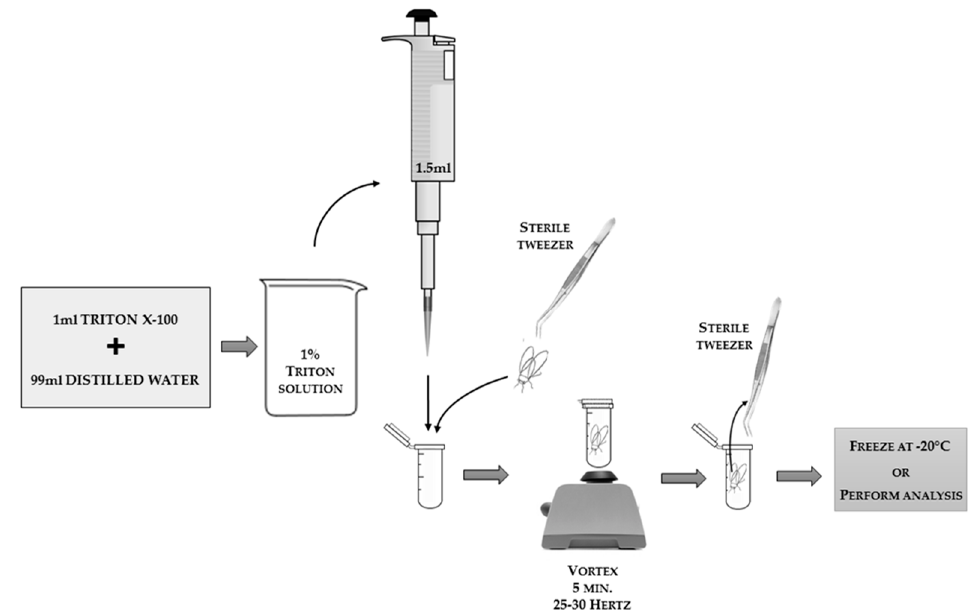
Figure 5. The scheme of the technique for obtaining insect body surface elution. The applied tools and reagents, along with suggested volumes, are presented in the scheme.